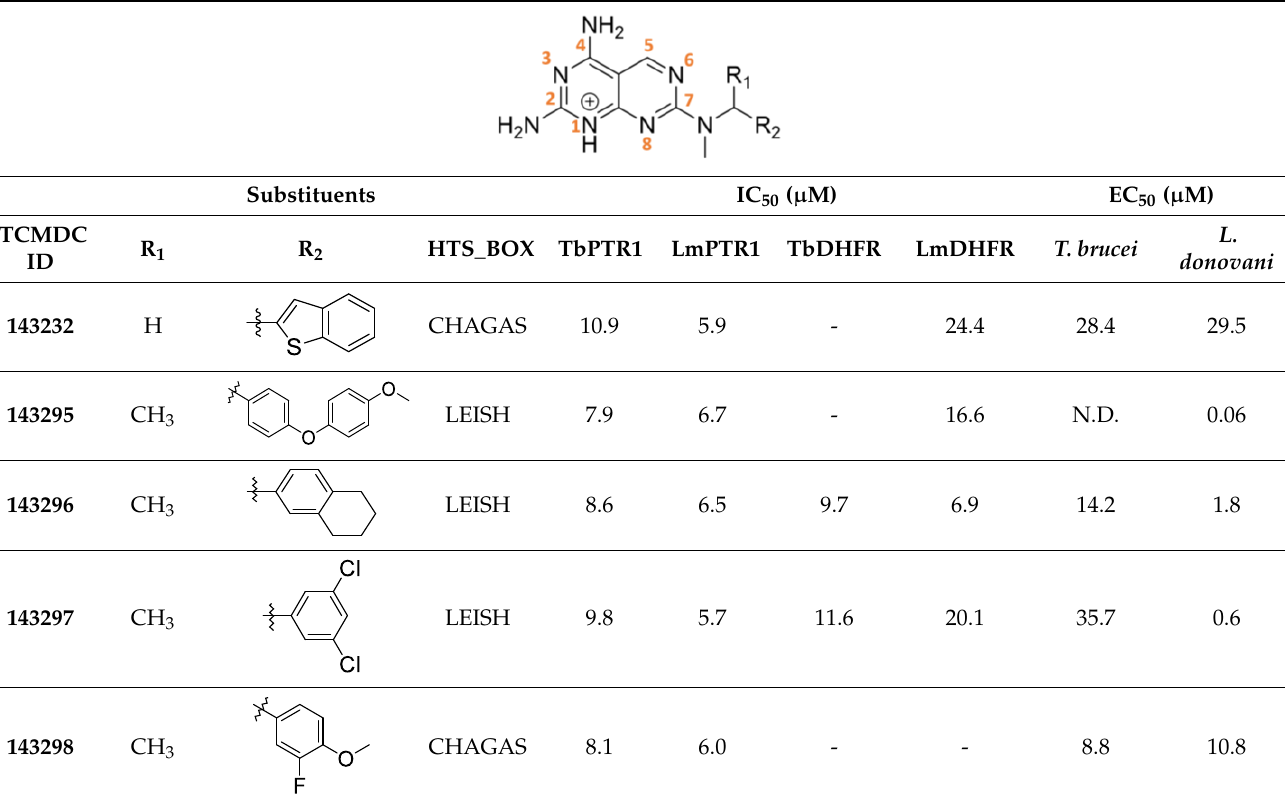
Table 2. Pyrimido-pyrimidine derivatives ( cluster VIII ).